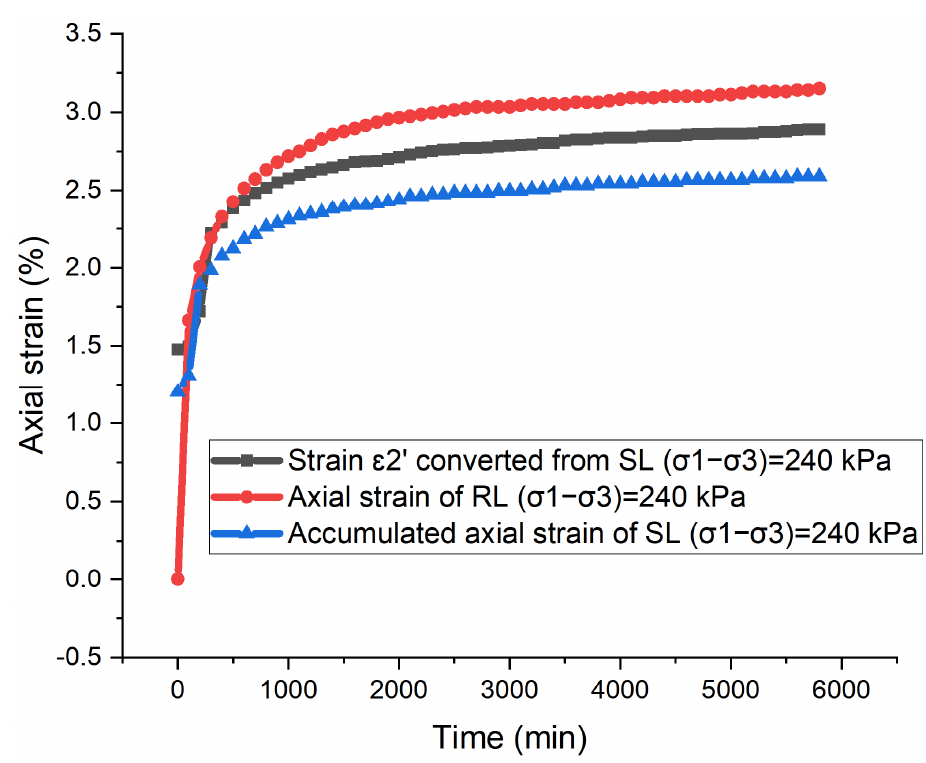
Figure 7. Comparison of converted RL axial deformation and tested RL and SL axial deformation when (σ − σ ) = 240kPa (Test 5, 3).